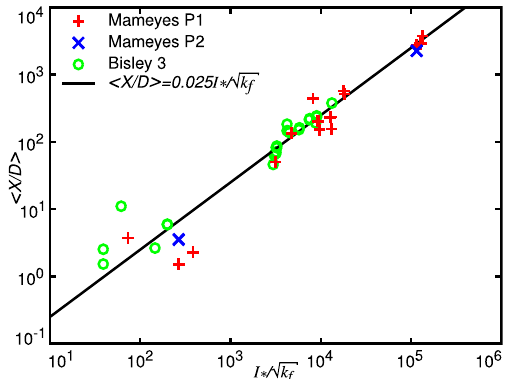
Figure 13. Collapse of the tracer data for the first (red + ) and second (blue x) Mameyes tracer populations, and Bisley 3 tracers (green o). The black line represents a linear relationship between the mean particle displacement and the dimensionless impulse over the dimensionless friction factor (Eq. 5). The grouping of the date is a result of surveys in three separate